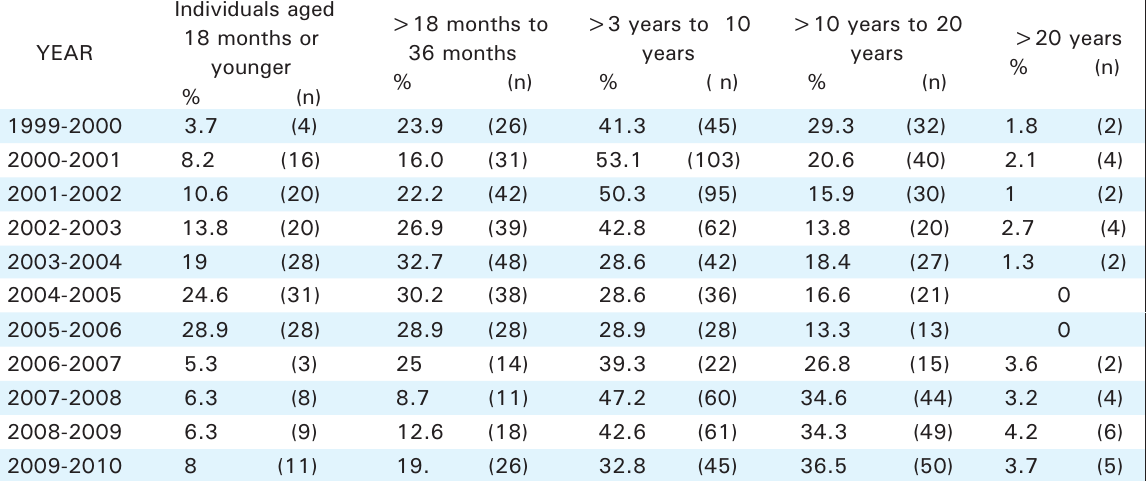
Table 4. Yearly distribution of percentage of individuals in different age groups at the time of palate repair